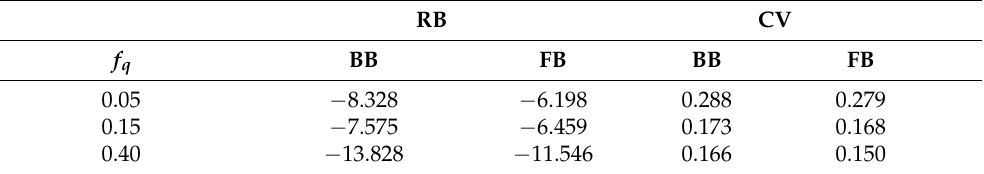
Table 2. Performance indicators for DGP 1 considering p = 0.4.